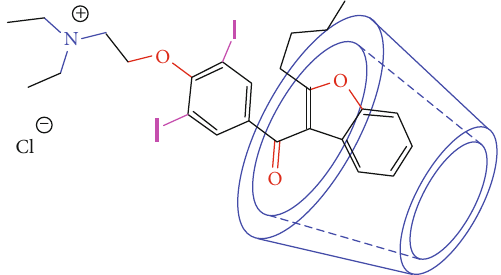
Figure 11: Proposed chemical structure of the inclusion complex of AMD into HP- β -CD